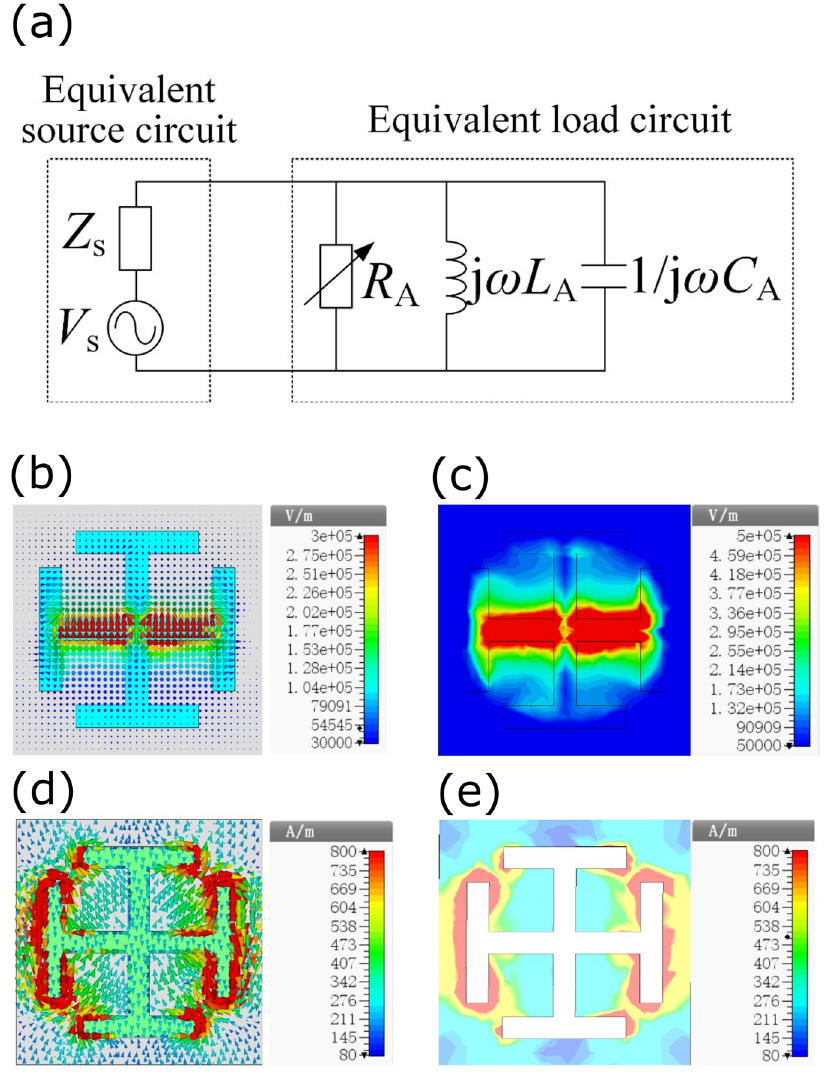
Fig. 2 Modeling and simulation of the Jerusalem-cross-slot metasurface. a Equivalent circuit model. b The vector of the electric fi eld. c The magnitude of the electric fi eld. d The vector of electric current. e The magnitude of electric current.